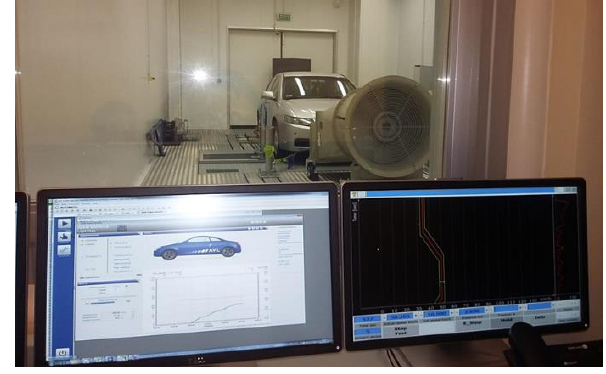
Fig. 1. View of the car on the test stand